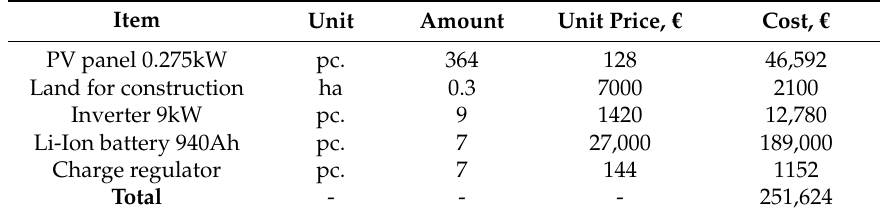
Table 6. Investment costs of a photovoltaic system with a hydrogen storage system (Scenario 3) [25,33,34,50–53].